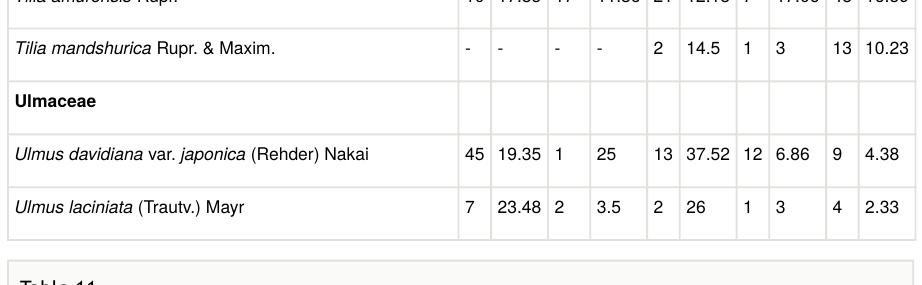
The characteristics of shrub community of fi ve forest types in Liangshui National Natural Reserve, where: UPF = Ulmus davidiana var. japonica — Pinus koraiensis forest; BPF = Betula costata